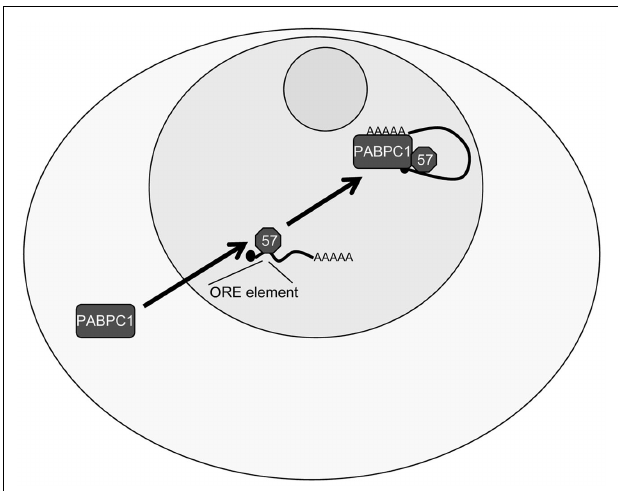
FIGURE 5 | Kaposi’s sarcoma-associated herpesvirus ORF57 enhances the translation of intronless viral mRNAs. As well as interacting with the hTREX complex in the nucleus, ORF57 also binds directly to the cellular protein PYM and recruits it to intronless KSHV mRNAs. ORF57 then shuttles through the nucleolus in an mRNP complex with the hTREX components, the intronless viral mRNA, PYM, and possibly other factors before exporting the mRNA. PYM recruits the 48S preinitiation complex to the viral mRNA, enhancing the pioneer round of translation in an ORF57-dependent